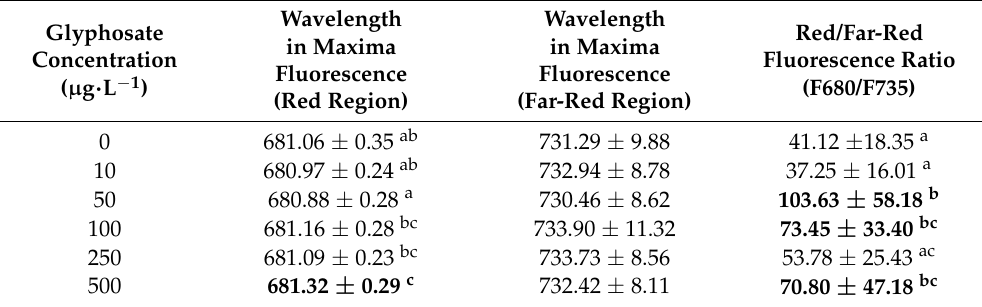
Table 1. The wavelength at maxima fluorescence in the red and far-red regions, and red/far-red fluorescence ratios (F680/F735) in Ulva lactuca following a 48-h exposure to a glyphosate-based herbicide formulation in different concentrations (mean ± s.d., n = 30, different letters indicate significant differences between treatments at p < 0.05; numbers in bold indicate significant deviation from